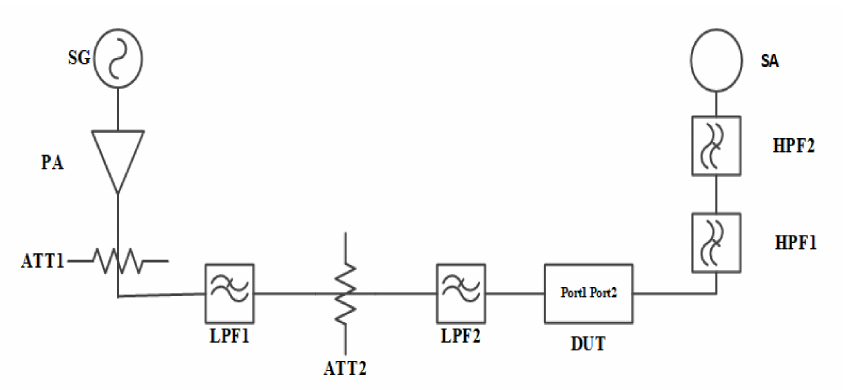
Figure 6. The nonlinear harmonic H2 and H3 measurement